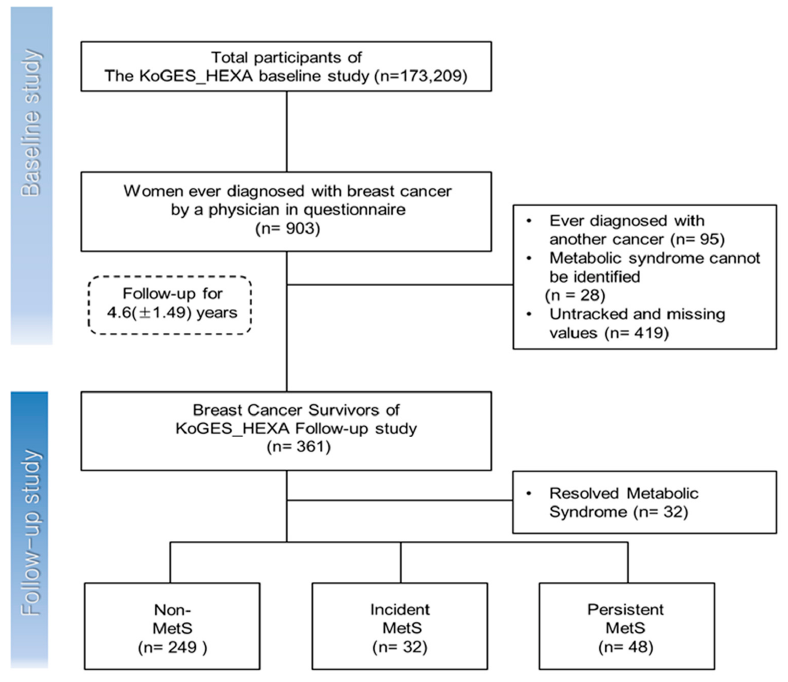
Figure 1. Selection process of subject.